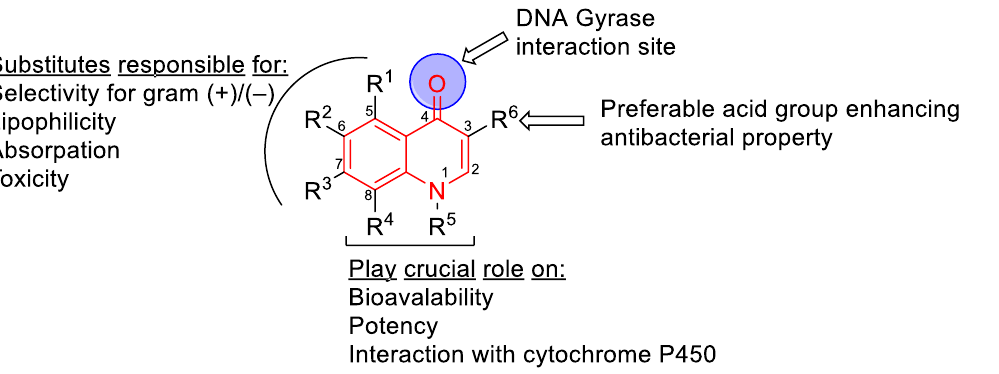
Figure 4. Quinolone core structure with six possible substitution locations for modification. The roles of substituents in biological activity are indicated.